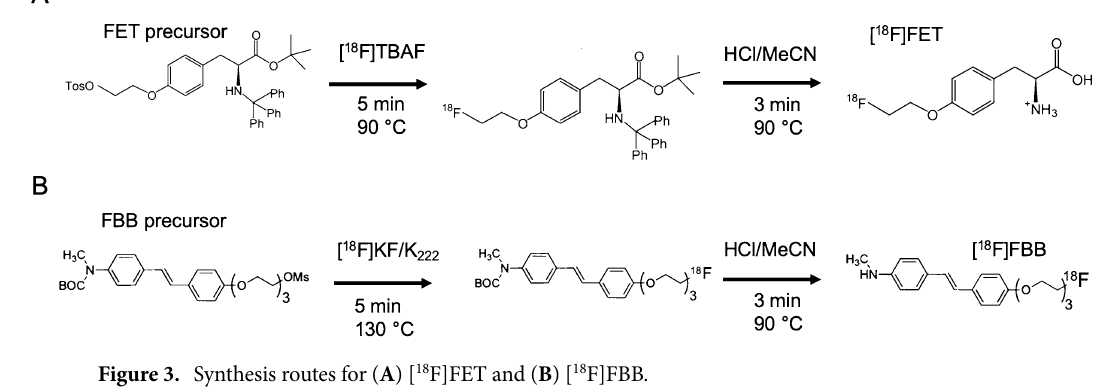
Figure 3. Synthesis routes for ( A ) [ 18 F]FET and ( B ) [ 18